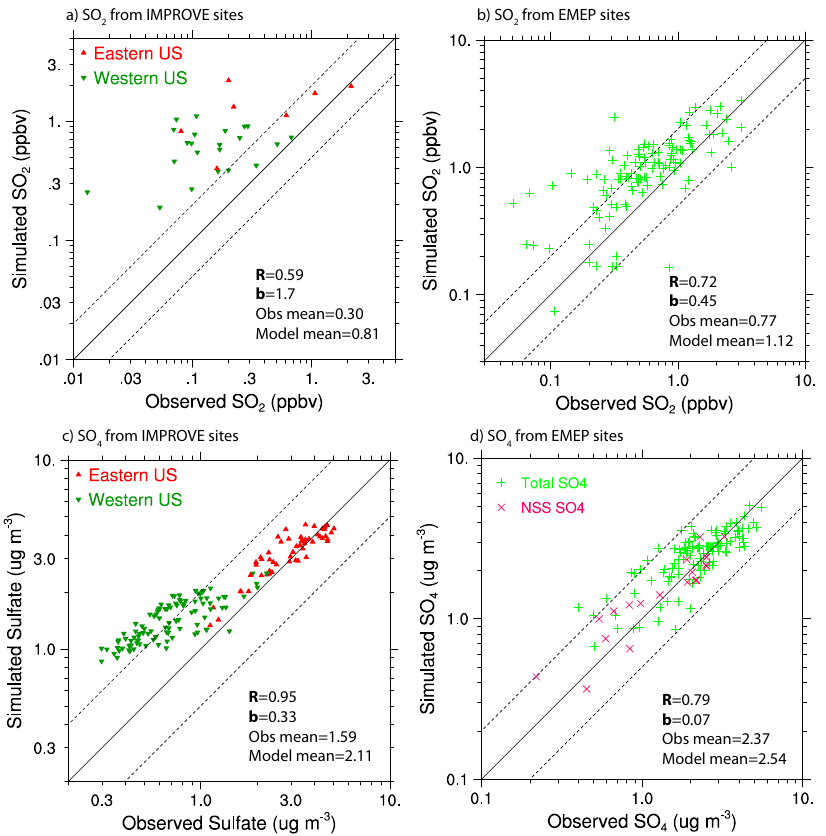
Figure 9 Fig. 9. Annual average simulated surface concentrations versus observations from the IMPROVE network and EMEP network: (a) SO 2 concentrations at the IMPROVE sites; (b) SO 2 concentrations at the EMEP sites; (c) sulfate concentrations at the IMPROVE sites; (d) sulfate concentrations at the EMEP sites. Model mean (“Model mean”), observational mean (“Obs mean”), normalized model mean bias (“b”) and the correlation coefficient between model and observations (“R”) are shown in each